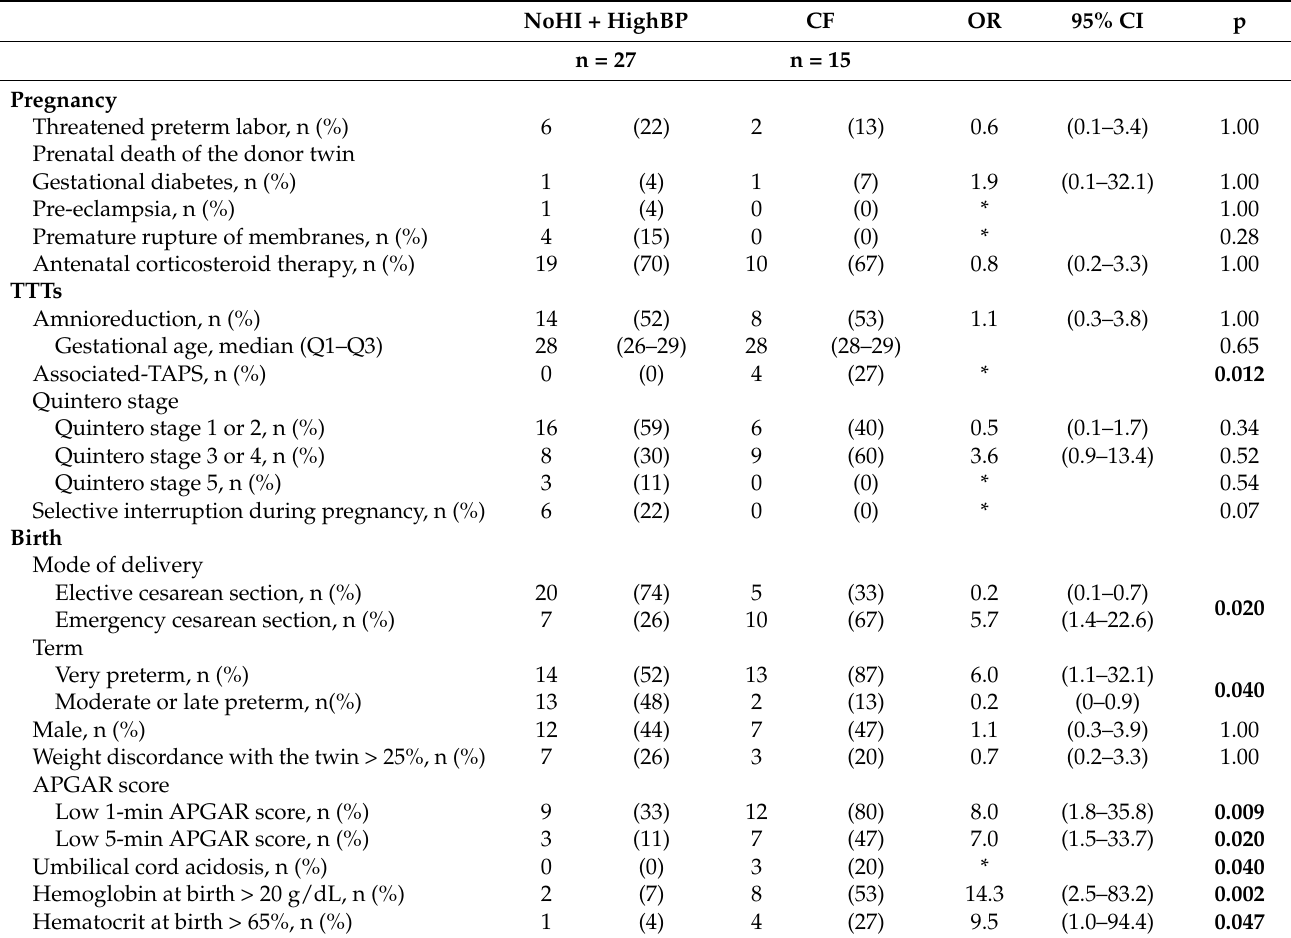
Table 3. Risk factors associated with cardiac failure (CF) in recipient twins. * No possibility of calculating Odds